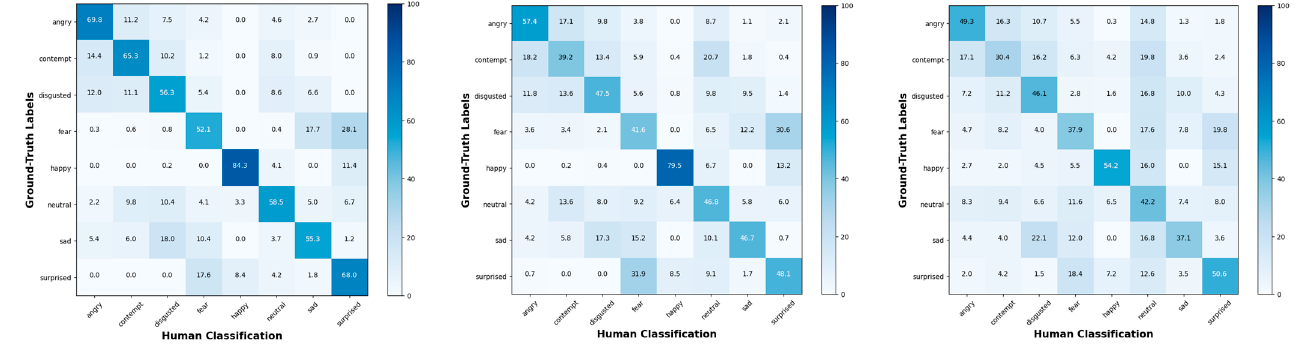
Figure 7. User study results of the human emotion classification confusion matrix. Ground truth video ( left ), and video generated on the basis of our proposed method ( middle ) and Wang et al. [10] ( right ).